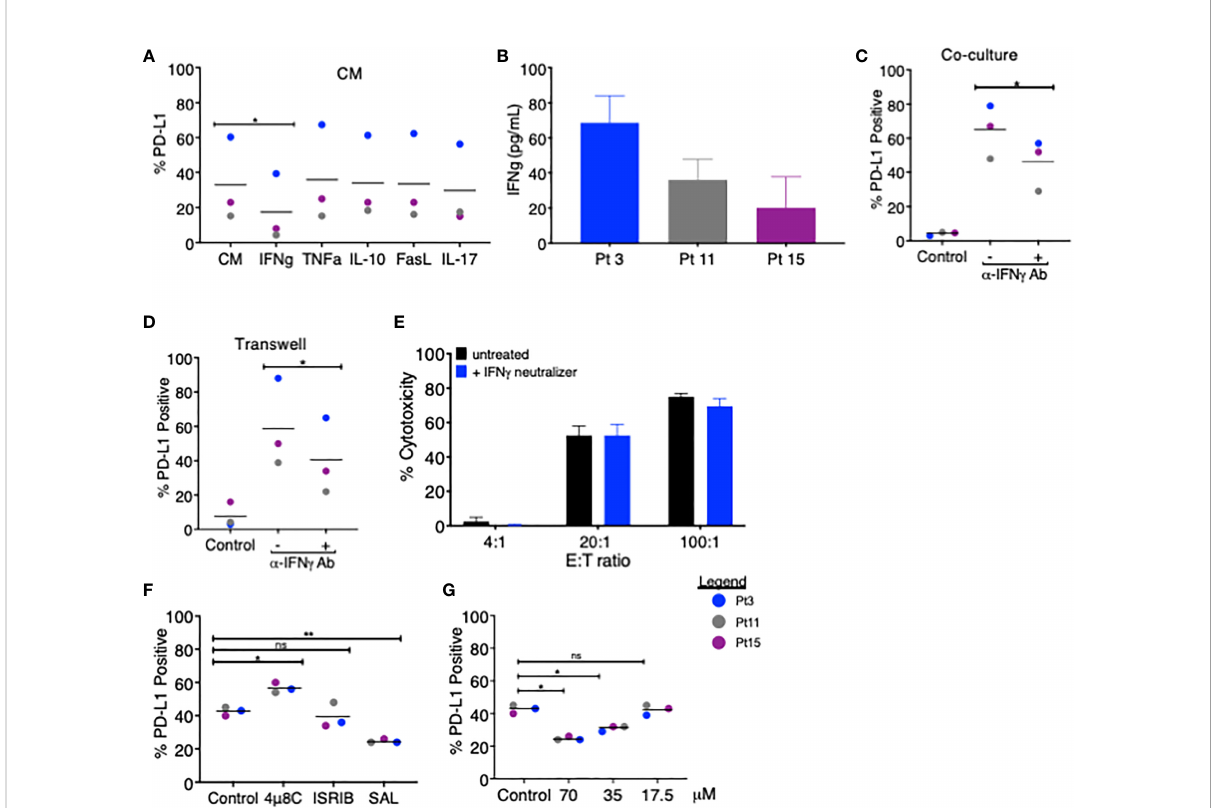
FIGURE 2 Blockade of IFN g and PERK pathways partially attenuates PD-L1 upregulation on MDS cells. (A) MDS cells from three patients were analyzed for PD-L1 expression via fl ow cytometry after 18 – 20 h of treatment with coculture CM in the presence of blocking antibodies for IFN g , TNF a , IL-10, FasL, or IL-17. (B) The amount of IFN g in the CM of cocultures of MDS cells and autologous tumor-speci fi c T cells from three patients was quanti fi ed using the QBeads supernatant assay. (C) MDS cells from three patients were analyzed for PD-L1 expression after an 18 – 20-h coculture (C) or in Transwell coculture (D) systems in the presence of an IFN g neutralizer. (E) Neoantigen-speci fi c T cells from Pt 3 were incubated overnight with autologous MDS cells at three effector:target (E:T) ratios with or without an IFN g neutralizer. (F) MDS cells from three patients (Pt 3, 11, and 15) were analyzed for PD-L1 expression after an 18 – 20-h coculture with autologous tumor-speci fi c T cells in the presence of 4µ8C (30 µM), ISRIB (1 µM), or Salubrinal (SAL, 70 µM). PD-L1 positivity was calculated by subtracting the percentage of PD-L1- positive cells at baseline from the percentage of PD-L1-positive cells after coculture. (G) MDS cells from three patients were analyzed for PD-L1 expression after 18 – 20 h of coculture with autologous tumor-speci fi c T cells in the presence of 17.5, 35, and 70 µM Salubrinal. PD-L1 positivity was calculated as in panel (A) p values are the result of paired t-test, and bars represent the median. *p < 0.05, **p < 0.01. ns, not signi fi